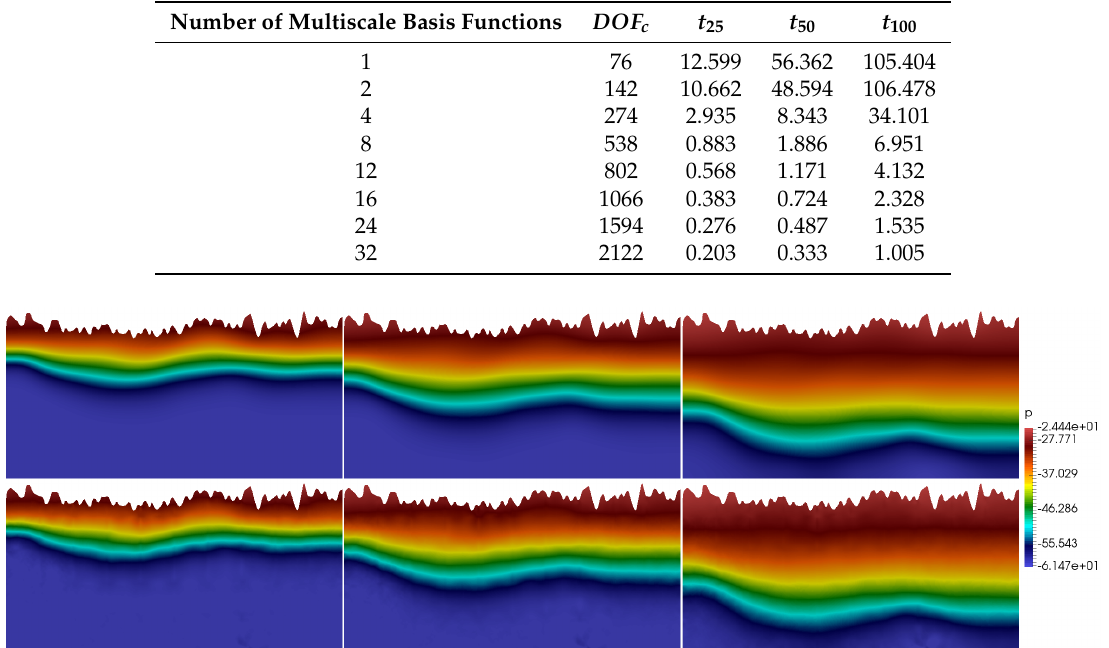
Figure 11. Numerical results for Test 2.NBC . Solutions p and p ms for different times: t 25 , t 50 , and t 100 (from left to right). First row: Fine-scale solution DOF f = 13,760. Second row: Multiscale solution using 16 basis functions DOF c = 1066. Table 5. Numerical results for Test 2.NBC . Relative L 2 error (%) for different numbers of multiscale basis functions.